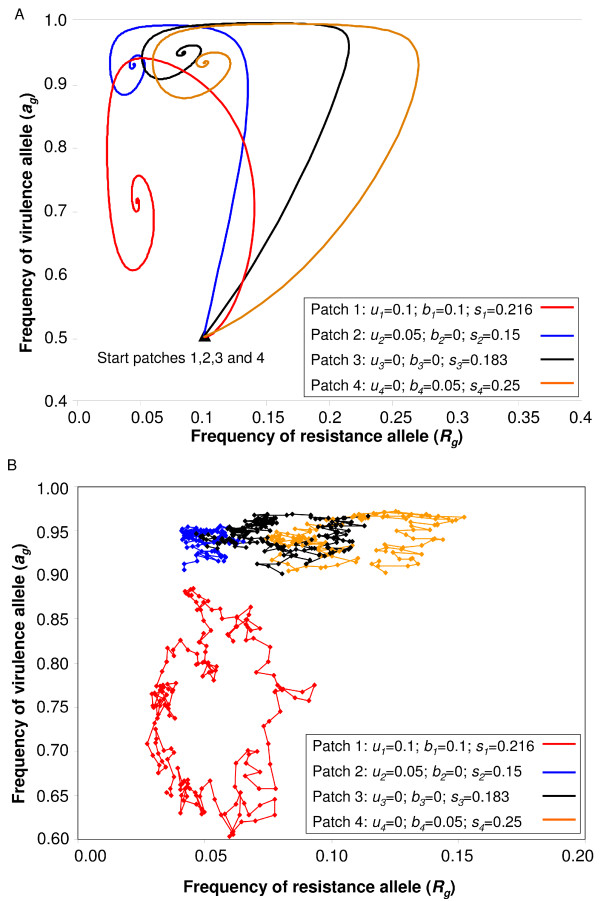
Dynamics of allele frequencies in n = 4 patches with different costs of resistance and virulence. Patches are characterised by variation of b, u, and s. Patch 1 (red) therefore represents a sub optimal environment for RES plants and avr parasites, while Patch 3 (black) represents an optimal environment for RES hosts and avr parasite as the costs of these alleles are zero. Patches 2 (blue) and 4 (orange) are respectively environment in which only RES and avr alleles are costly. In the four patches, the initial RES frequency is 0.1 and avr frequency is 0.5. The model was run for 1000 generations, and mH = mP = 0.05. a) Stable dynamics appear as inward spiralling towards the four different equilibrium points in an infinite deterministic population model. b) Trajectory of allele frequencies for one cycle in each patch, showing irregular, anti-clockwise cycling around the stable equilibrium in a stochastic finite population model (Only the last 200 generations over 1000 are shown).